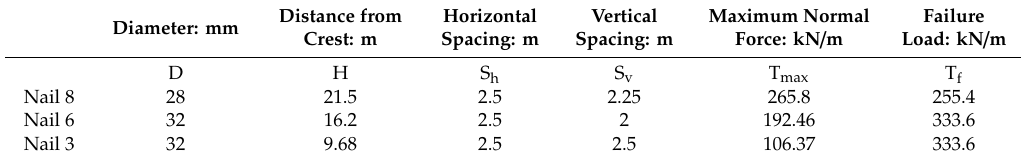
Table 4. Maximum normal force in the soil nail results.